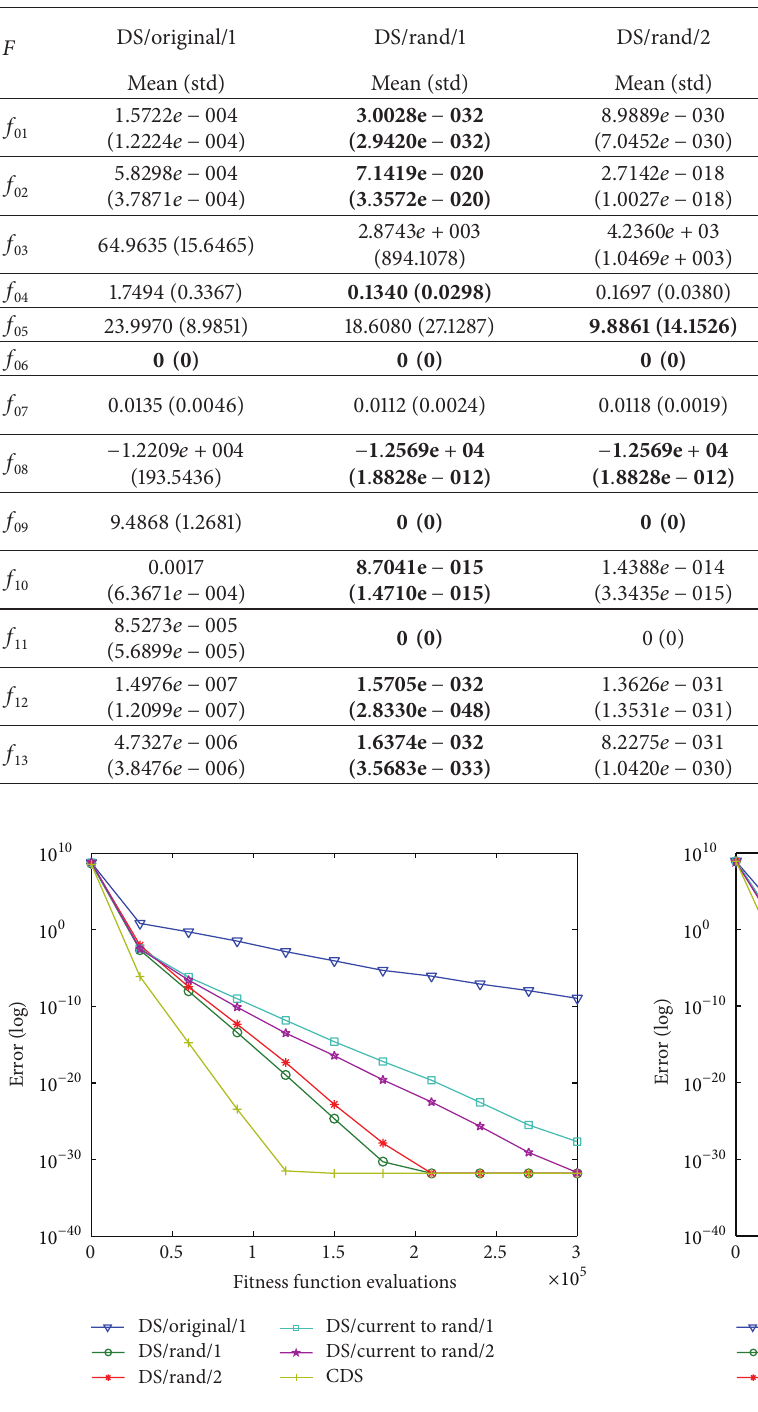
Figure 12: Comparison of performance of six algorithms for minimization of 𝑓 13 with dimension